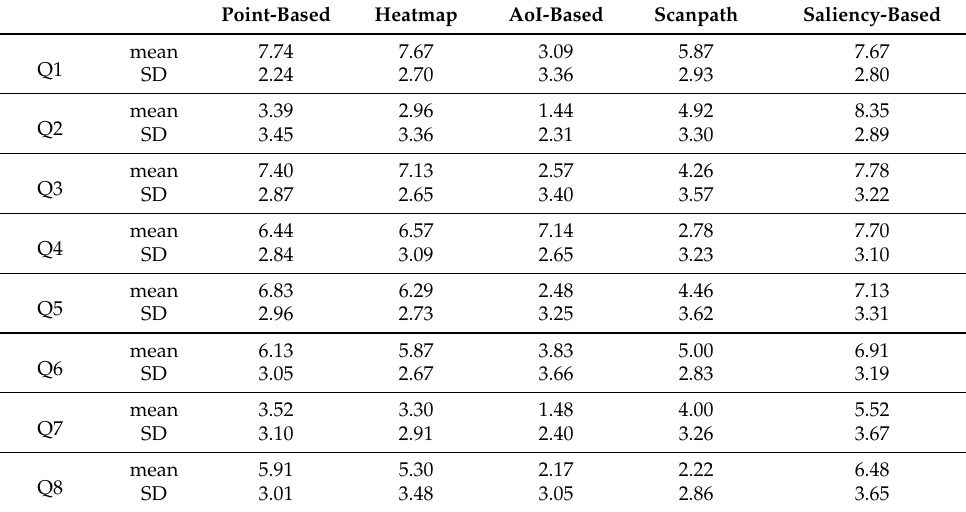
Table 3. The average scores for point-based, heatmap, AoI-based, scanpath, and saliency-based gaze data